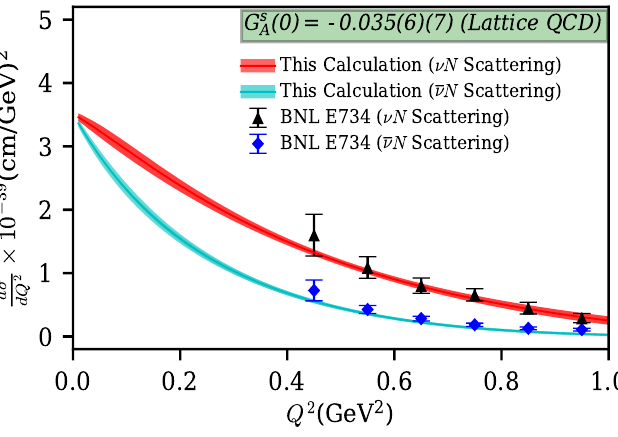
Figure 4 . Prediction of BNL E734 experiment ( (cid:23) ) (cid:23) (cid:0) N di(cid:11)erential cross sections. The very mild e(cid:11)ect coming from the neutrino beam energy (cid:14)E (cid:23) = (cid:6) 0 : 1 GeV is added as a systematic in the d(cid:27)=dQ 2 extraction and shown in the outer light red and light cyan bands. G Z determined from the lattice QCD calculation of G s using the z -expansion (cid:12)t, are used here for the prediction of ( (cid:23) ) (cid:23) (cid:0) N di(cid:11)erential cross sections.